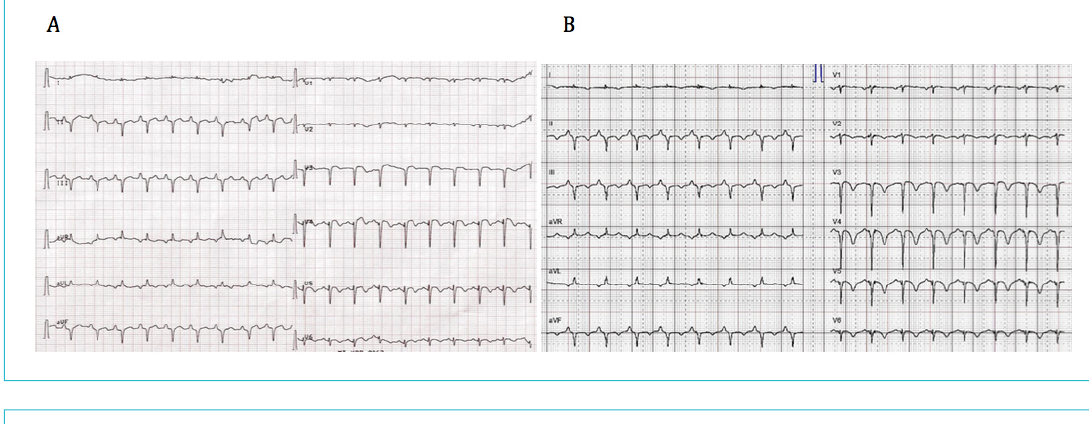
Figure 2: Complete heart block requiring cardiopulmonary resuscitation in a male patient with Takotsubo